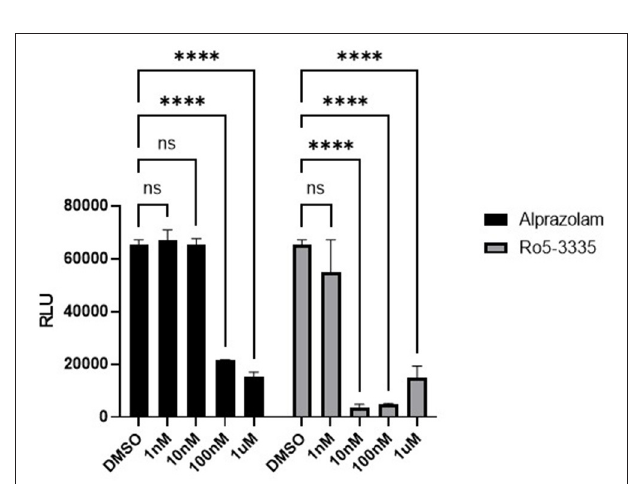
FIGURE 3 | Effect of alprazolam on IL17. 293T cells were transfected with IL17-luciferase reporter plasmid and treated with Ro5-3335 or alprazolam. Luciferase activity was measured using a luciferase assay kit. Luciferase light units after treatment with RO5-3335 or alprazolam with overexpression of RUNX1. **** P ≤ 0.0001, ns = not significant.